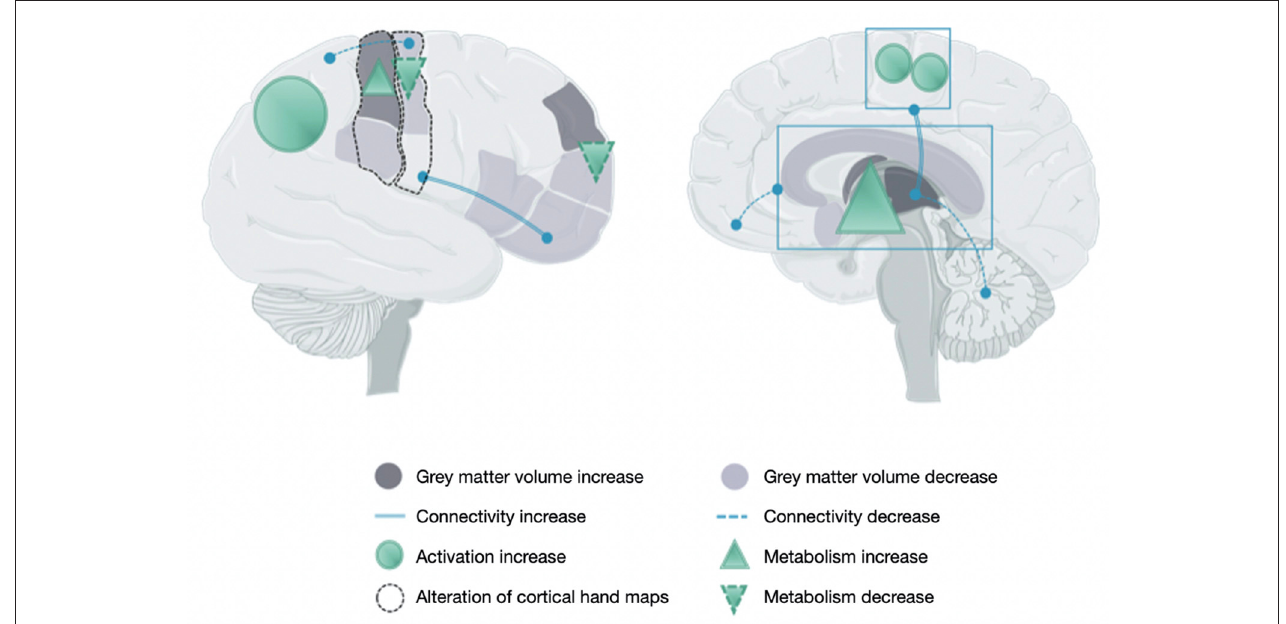
FIGURE 1 | Brain changes in people with a complex regional pain syndrome. This figure illustrates the main data reported in Table 2 owing to the increase or decrease of gray matter volume, connectivity, activity, and metabolism and the alteration of maps related to hand sensorimotor function.